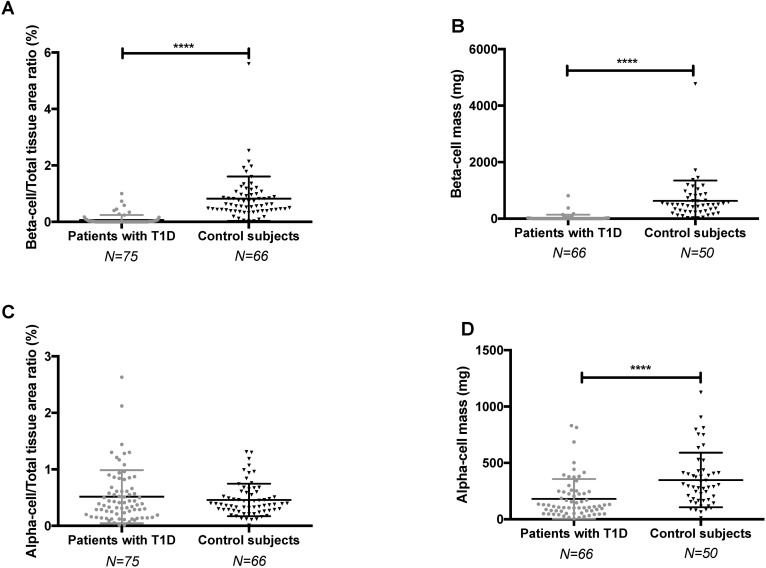
β- and α-cell to total tissue area ratio and β- and α-cell mass in patients with T1D and control subjects.A: β-cell area/total tissue area ratio. B: β-cell mass. T1D patients are symbolized by grey circles and controls by black triangles. Bars represent mean with SD and data were analyzed using the Mann-Whitney test. ****p<0.0001.